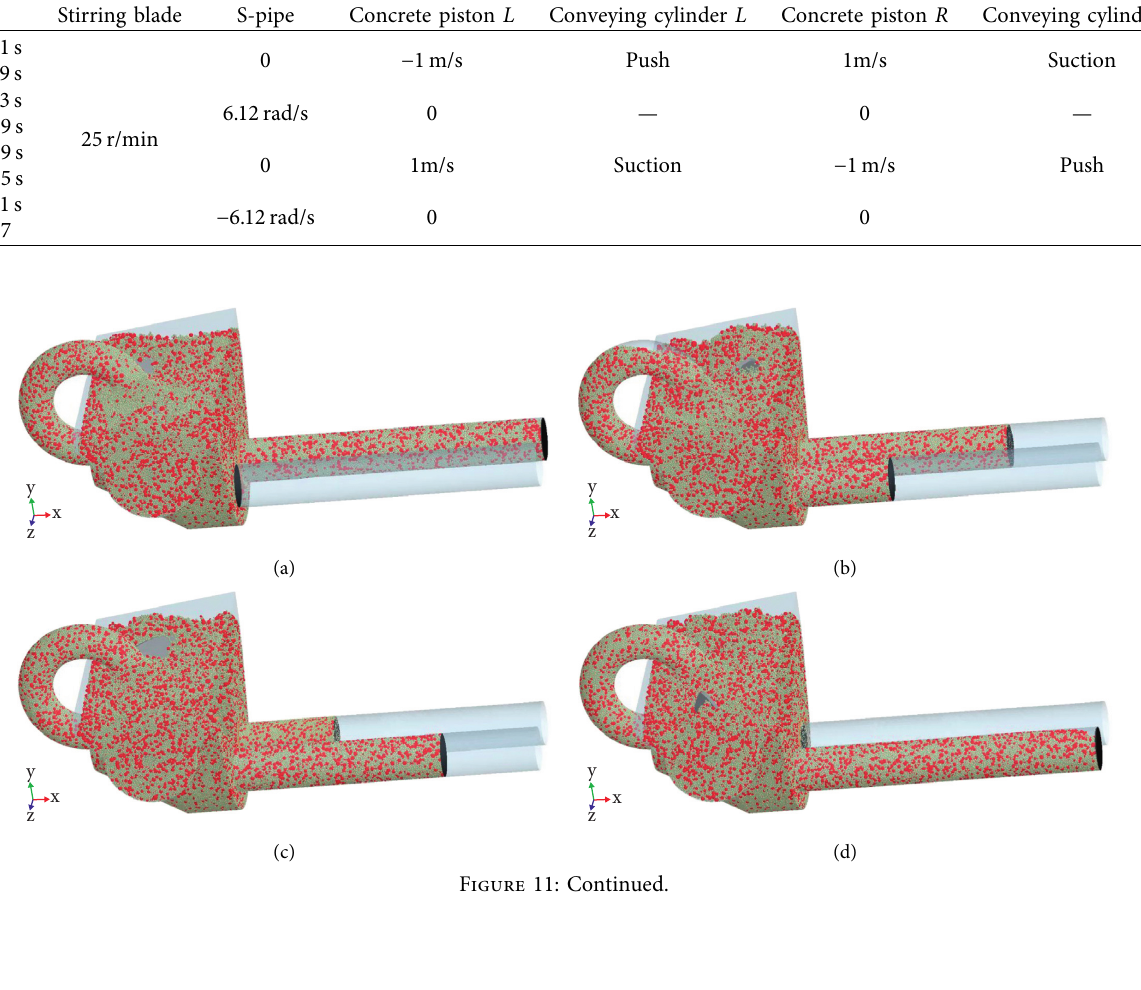
Figure 10: The relationship between the parameter k and suction efficiency. Table 3: The movements of geometries.